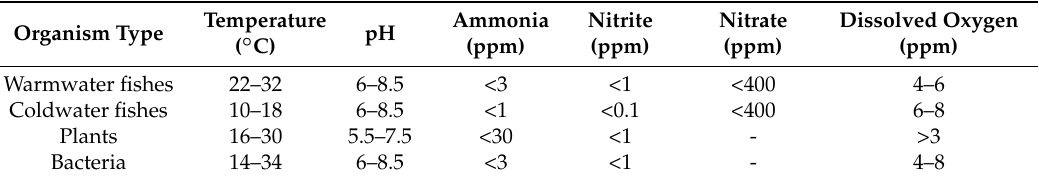
Table 1. General water quality tolerances for fish (warm or coldwater), hydroponic plants and nitrifying bacteria (from Somerville et al.